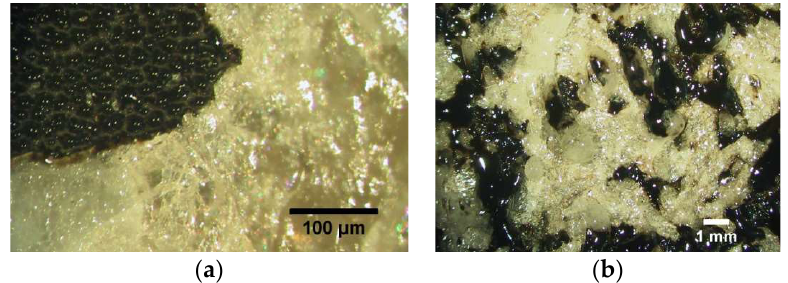
Figure 6. Raman spectrum for the different phases distinguished in the black granite prior and after the laser blasting process.